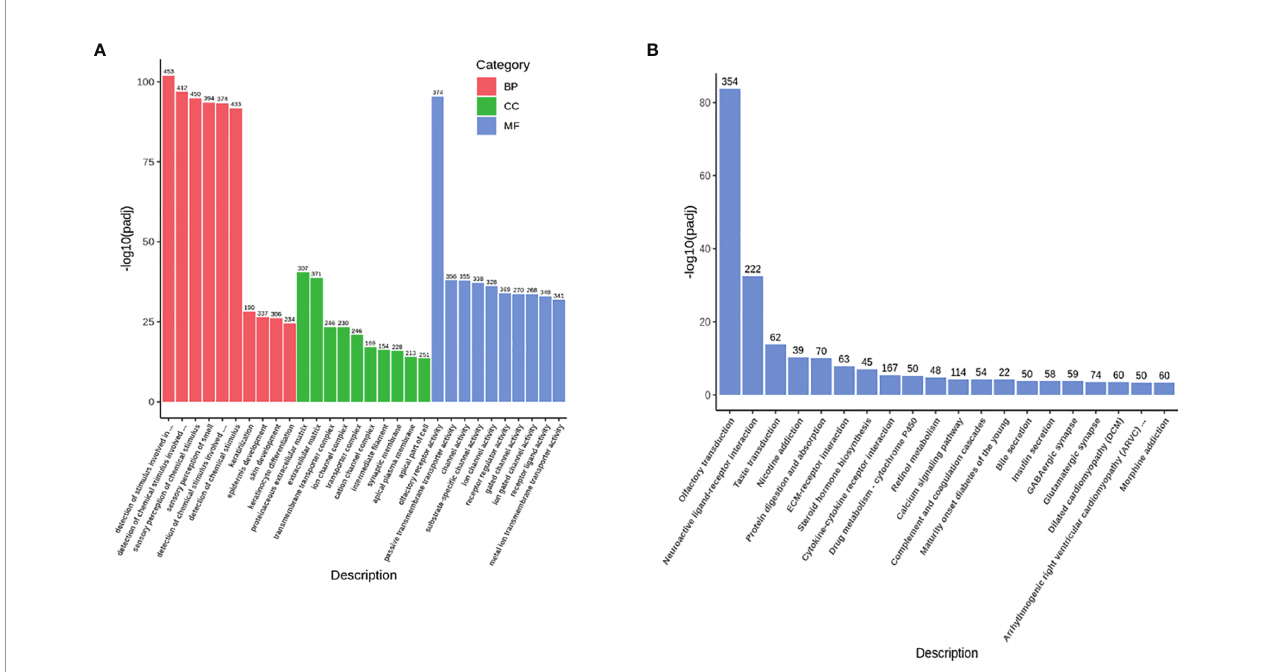
FIGURE 1 | The outline of the RNA-Seq results. (A) The GO enrichment items with upregulated genes (33788 genes). The abscissa shows the GO terms, the ordinate shows the signi fi cance value (p-adj) of each GO term, and the number at the top of each histogram indicates how many changed genes in each GO term. Different colors represent the three GO subcategories biological process (BP), cellular component (CC), and molecular function (MF). (B) The KEGG enrichment items with upregulated genes (33788 genes). The abscissa shows the KEGG terms, the ordinate shows the signi fi cance value (p-adj) of each KEGG term, and the number at the top of each histogram indicates how many changed genes in each KEGG